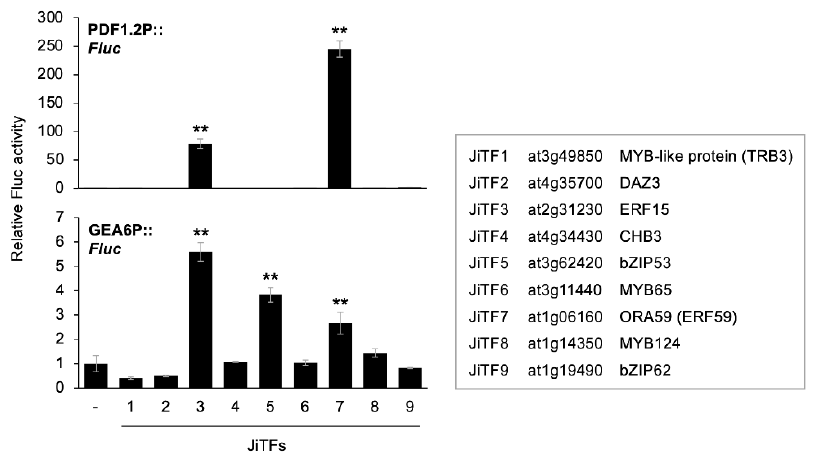
Figure 1. Transcriptional activity of JiTFs. Transient activation of a firefly luciferase (Fluc) reporter gene under the control of PDF1.2 promoter (PDF1.2P) or GEA6 promoter (GEA6P) following ex- pression with or without ( − ) JiTFs in Arabidopsis thaliana protoplasts. Data represent the mean and standard error ( n = 5). Data marked with asterisks are significantly different from those obtained without JiTFs , based on an ANOVA with Holm’s sequential Bonferroni post hoc test (**, p < 0.01).